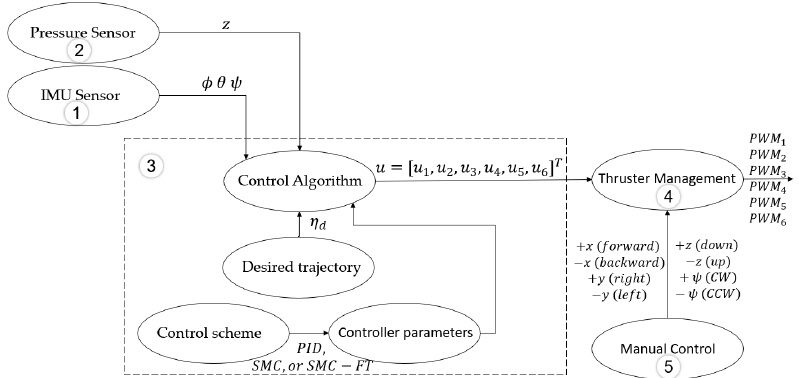
Figure 6. BlueROV2 ® software